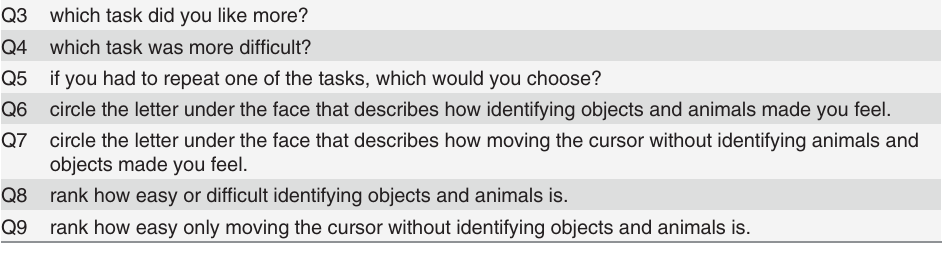
Table 1. List of survey questions administered to all participants after the completion of both